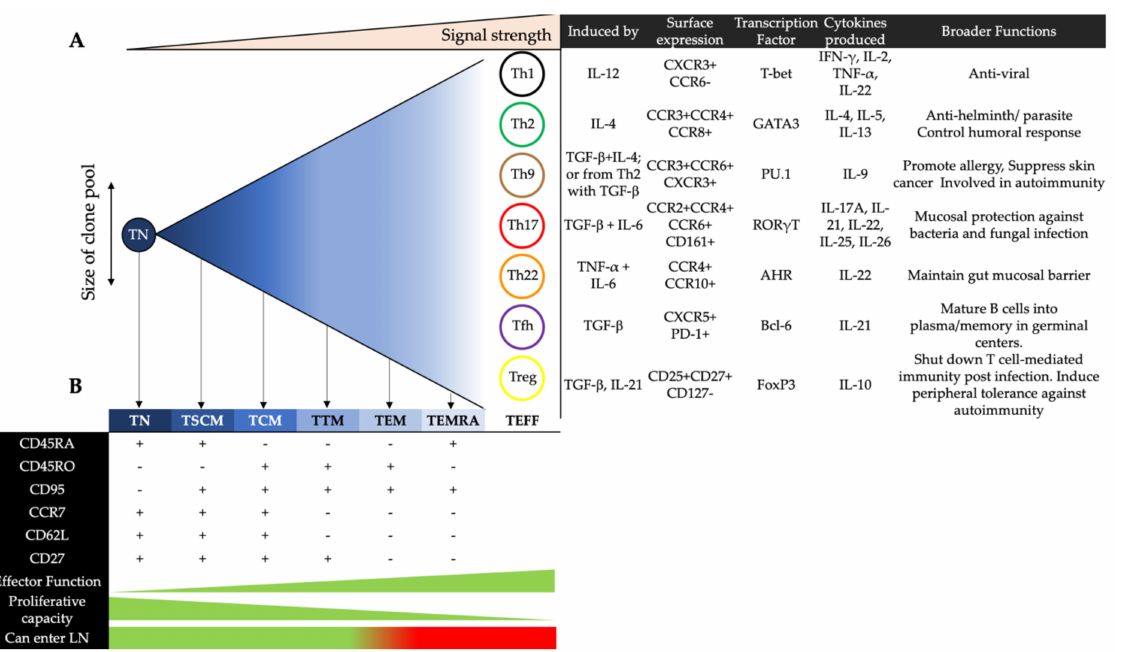
Figure 1. The linear model of progressive differentiation. ( A ) The differentiation of a naïve T cells (TN) cell into an activated phenotype that ultimately results in cell death. Once a CD4 + T cell reaches its full differentiation potential, and depending on stimuli, it can be defined as one of seven major effector helper subsets, with distinct surface markers, cytokine secretion profiles and overall functions. ( B ) As a cell progresses down this linear path, it may diverge at any point depending on the strength and consistency of the stimulus. This divergence results in a memory cell phenotype depending on the early level of differentiation the cell has already experienced. These memory cells are defined by the expression of a range of surface markers and are distinguished by the strength of effector functions and proliferative capacities. According to this model, once a memory cell is reactivated, the cell must only travel down the linear progression to become a short-lived effector T cell (TEFF). This process cannot be reversed to an earlier